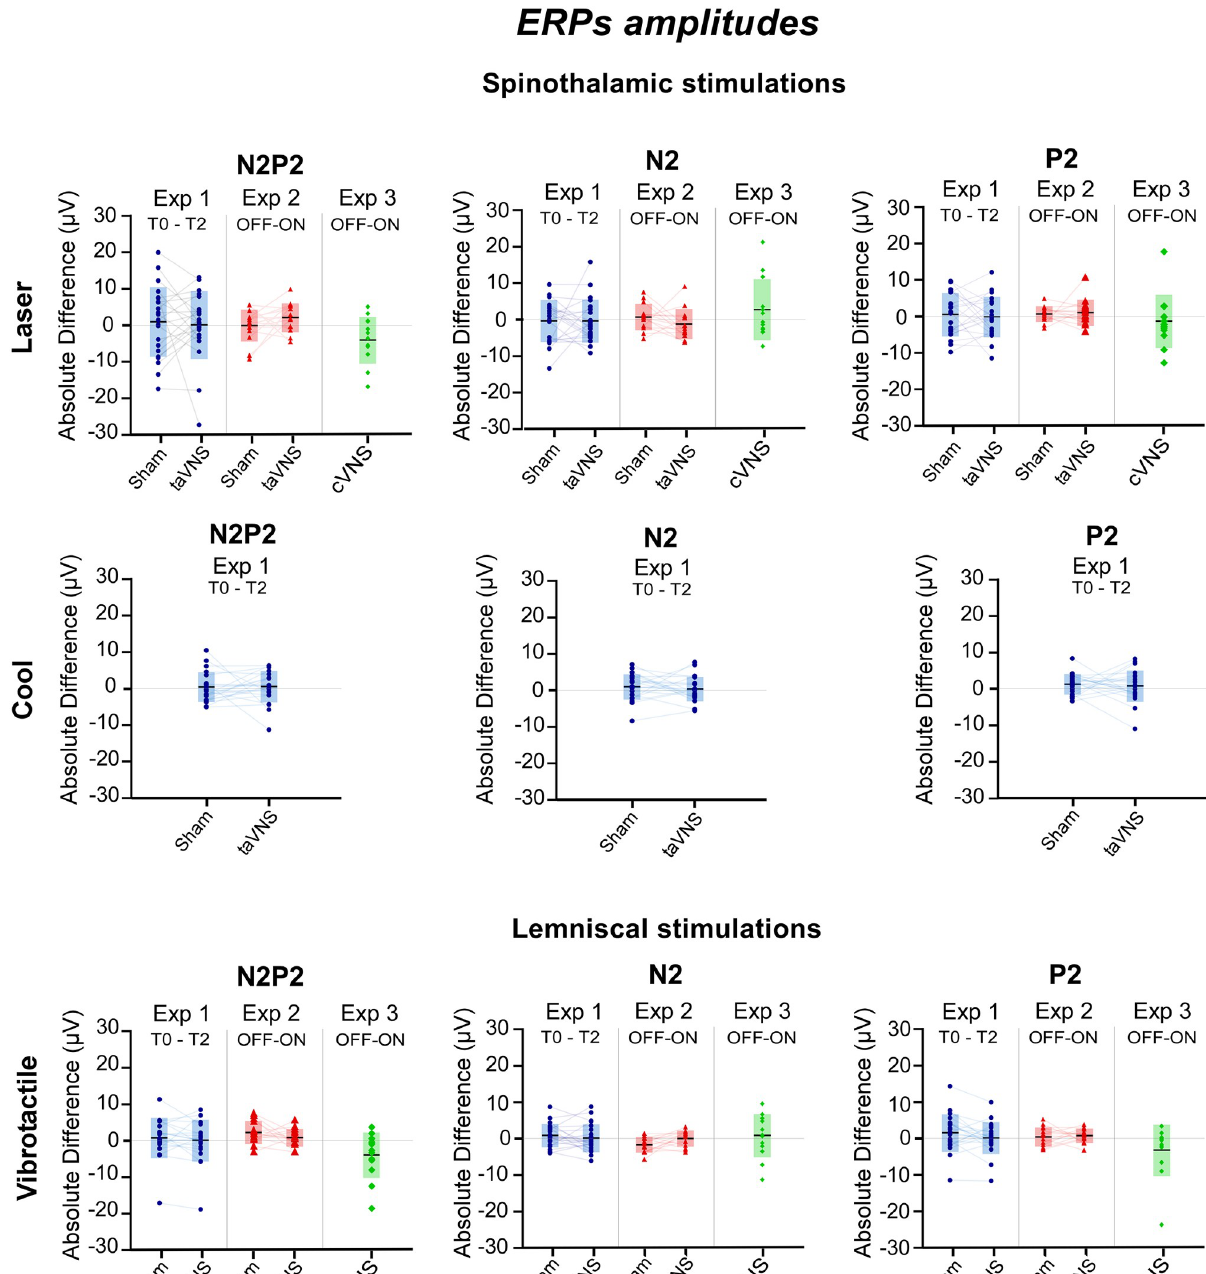
Fig 6. ERPs: Peak amplitudes. Each diagram represents the absolute difference in the amplitudes of specific peaks (N2,P2,N2P2 amplitude) of one type of somatosensory-ERP (Laser-, Vibrotactile-, Cool-ERPs), recorded at a specific timepoint (T0,T2) or phase of the duty cycle (OFF,ON) under one experimental condition (sham, taVNS or cVNS). Within each diagram, individual values are shape-coded according to the experiment in which they were retrieved (circles for Experiment 1, triangles for Experiment 2, diamonds for Experiment 3). Grey boxes represent group statistics, with the central horizontal lines and top/bottom extremities indicating the means ± SD values. The Y axes represent the absolute difference (in μ V) measured between two recordings of a specific peak. The X axes indicate which timepoints or phases of the duty cycle are compared on the related Y axes. There were no statistically significant results